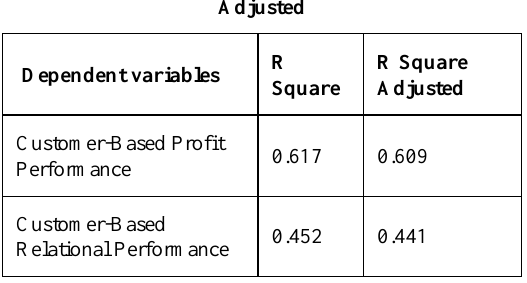
Table 5: Coefficients of Determination (R 2 ) and R 2